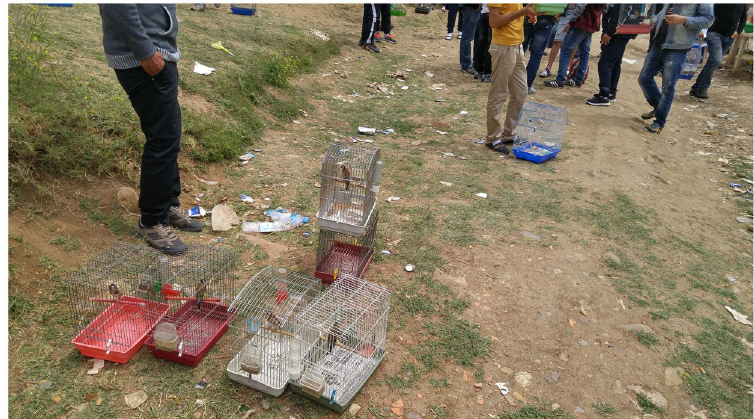
Figure 3. Illegal trading of the European goldfinch in the flea market of Algeria (Guelma